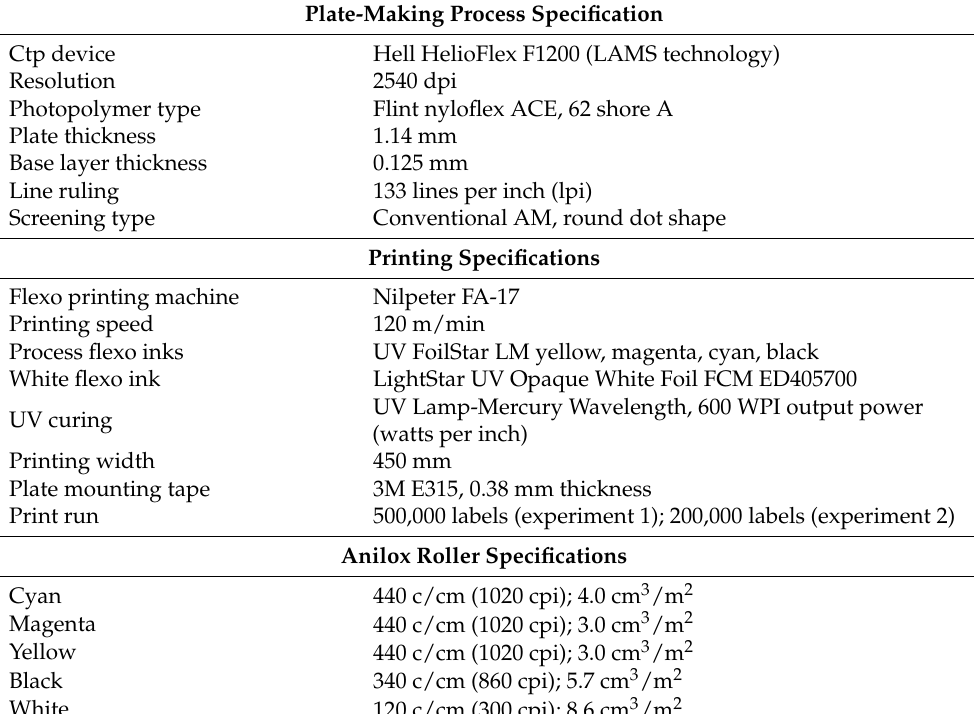
Table 1. Technical specifications of the prepress and printing